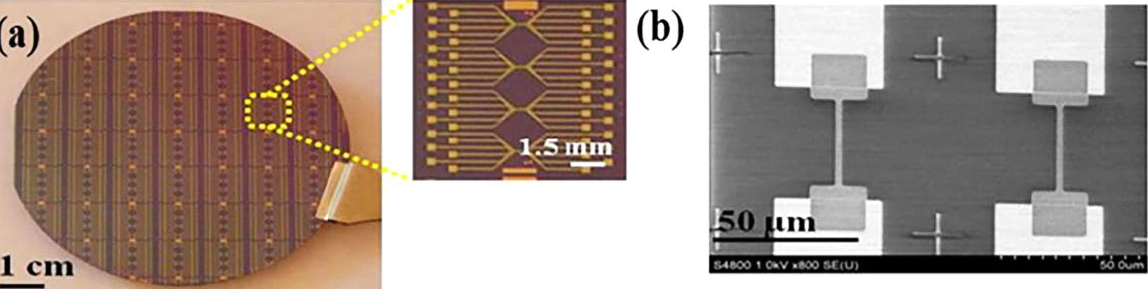
Figure 4. ( a ) Photograph of a 3-inch wafer with top-down fabricated In 2 O 3 nanoribbon FT biosensors. Inset shows a magnified image of a nanoribbon chip composed of four subgroups of six nanoribbon FETs; ( b ) SEM micrograph of the nanoribbon FETs showing identical device channels precisely positioned on the source and drain areas, reproduced with permission from Ref. [23]. Copyright © 2015, American Chemical Society.